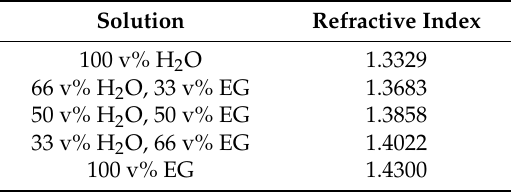
Table 1. Water–ethylene glycol solutions for the calibration measurement of the refractive index.